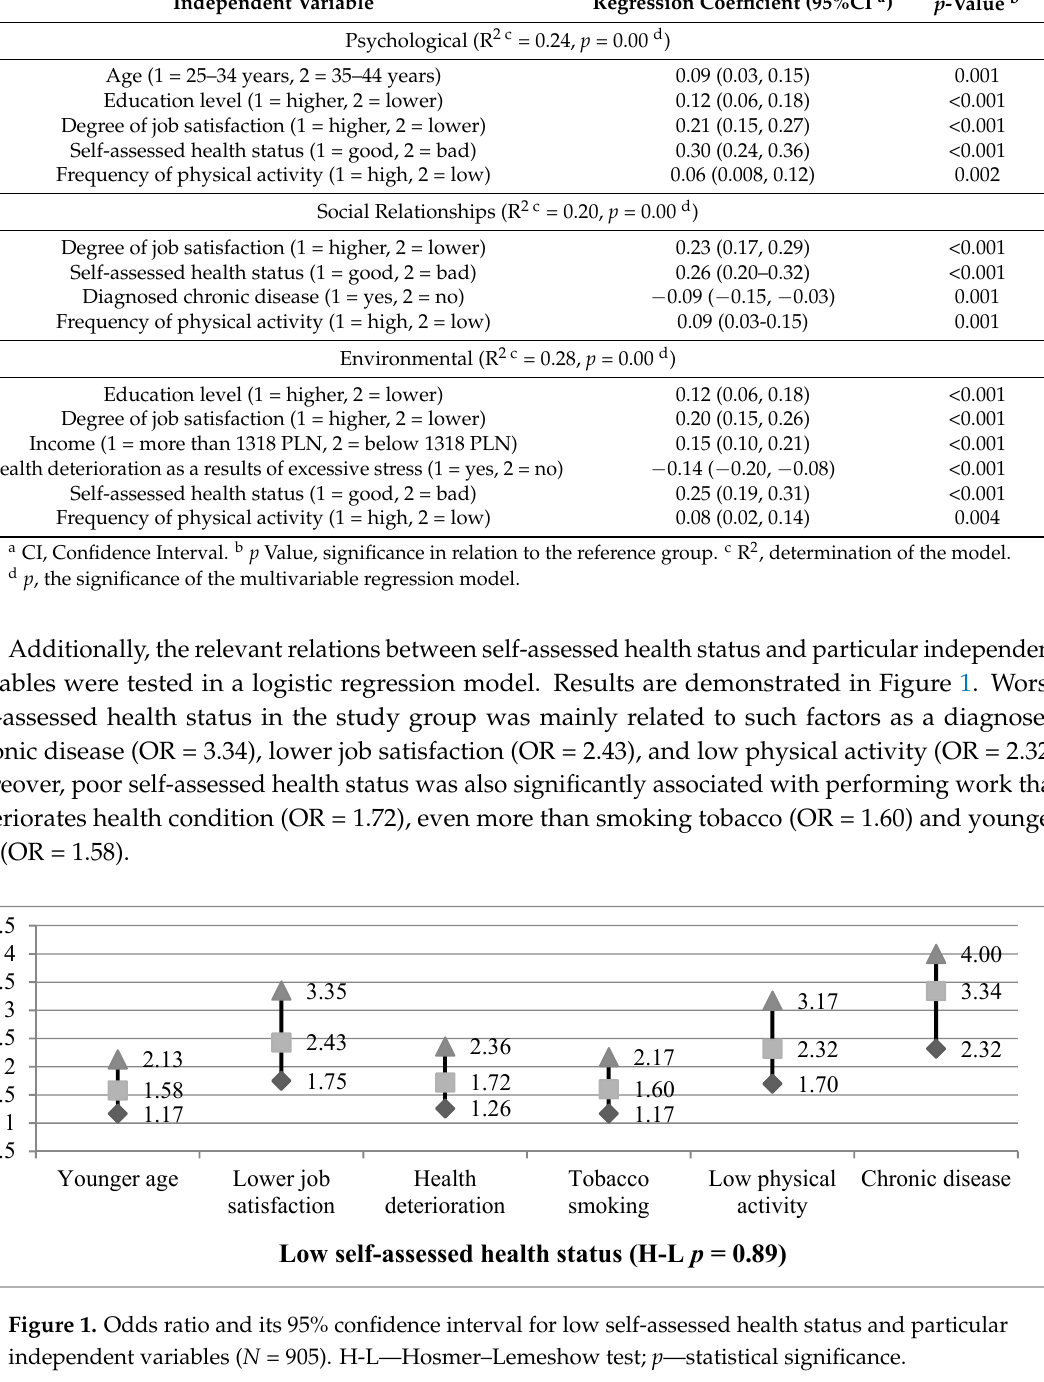
Figure 2. Odds ratio and 95% confidence interval for diagnosed chronic disease and particular independent variables ( N = 905).